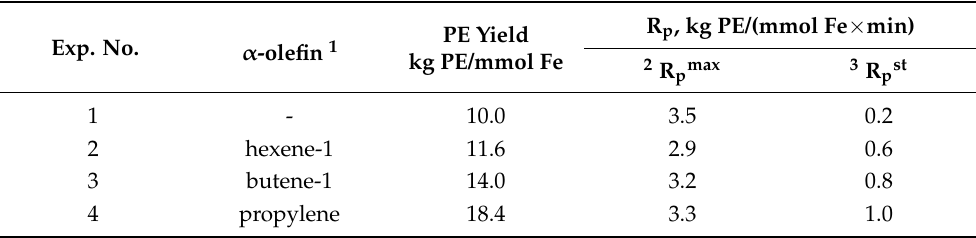
Table 2. Data on the effect of α -olefins on the polymer yield and polymerization rate for ethylene polymerization over the catalyst *LFeCl 2 /MMAO.